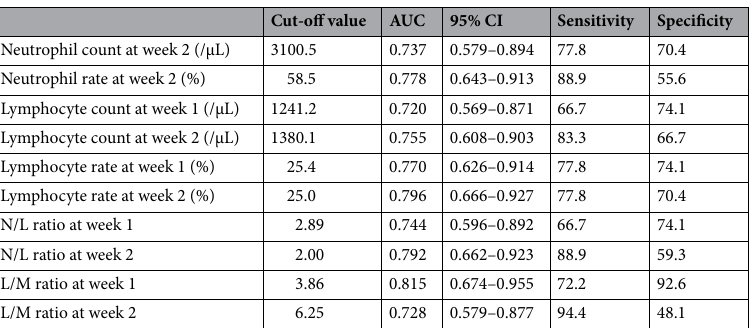
Table 3. Receiver operating characteristic analysis for prediction of treatment failure based on absolute count, rate, and subtype ratio during the 3-month follow-up period after reaching the tacrolimus high trough level. AUC, area under the curve; CI, confidence interval; N/L ratio, neutrophil to lymphocyte ratio; L/M ratio, lymphocyte to monocyte